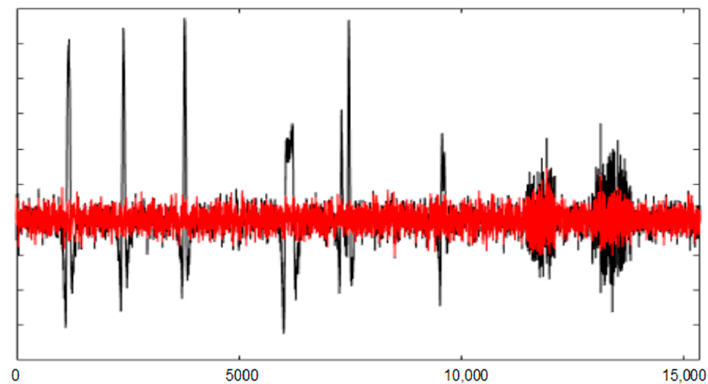
Figure 20. The AF8 channel of SEEG with (in black) and without artefacts (in red) after using MARA. The X axis shows the samples.